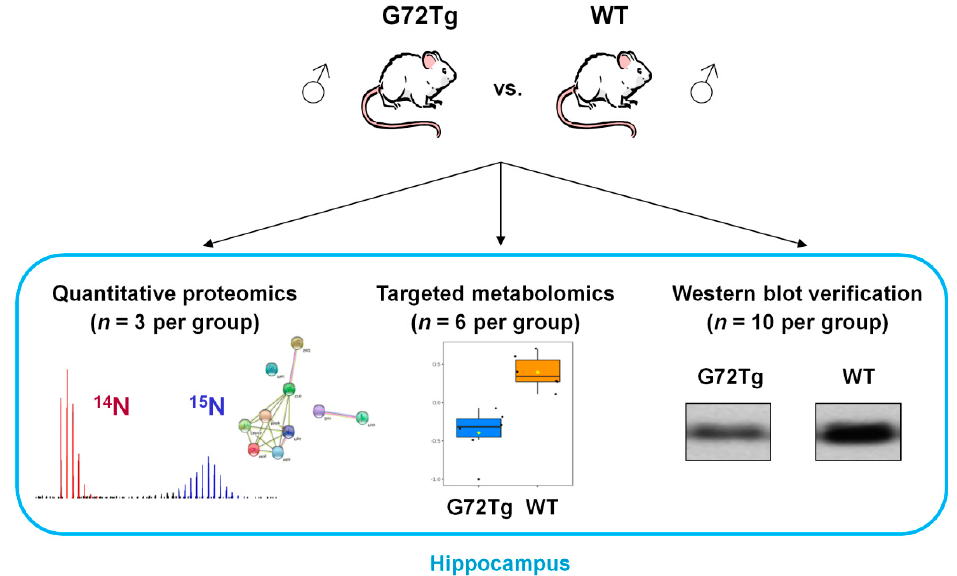
Figure 1. Experimental design. Transgenic mice carrying the G72/G30 locus (G72Tg) vs. wild-type (WT) male mice hippocampi were compared by 15 N metabolic labeling-based quantitative proteomics and targeted metabolomics. Selected protein expression alterations were verified in a larger cohort of G72Tg and WT mice.